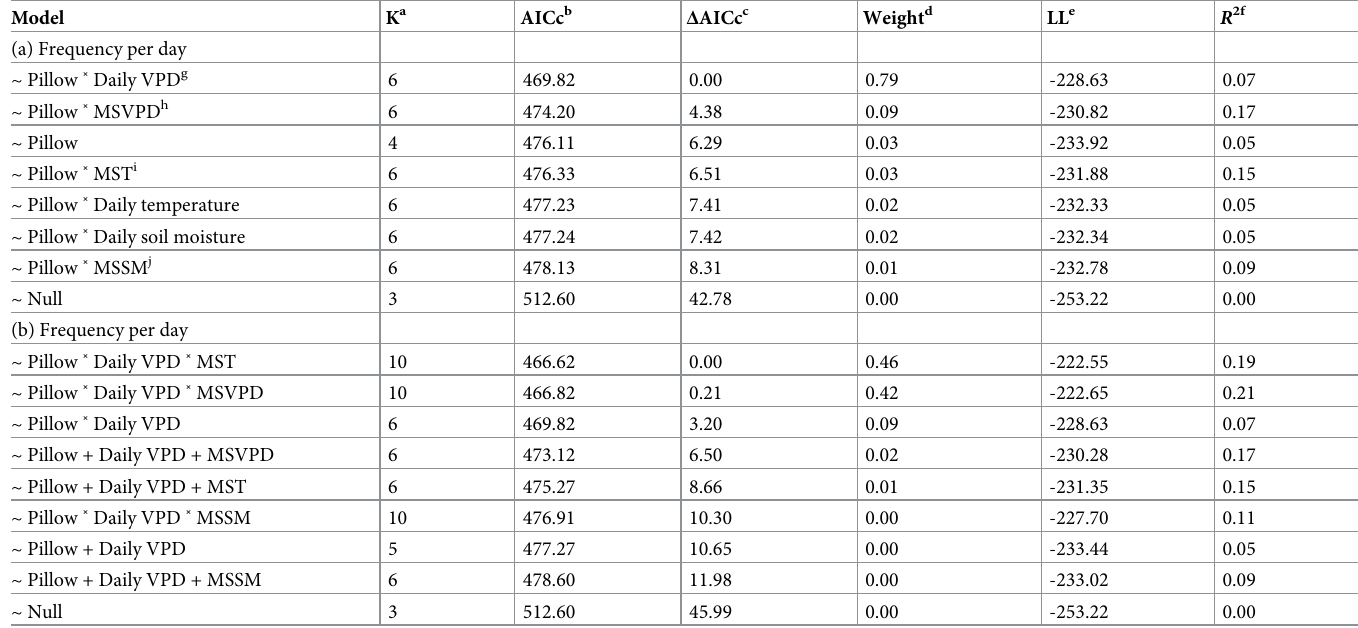
Table 2. Results comparing a set of candidate models to find the best predictor for variation in water demand behavior over time.